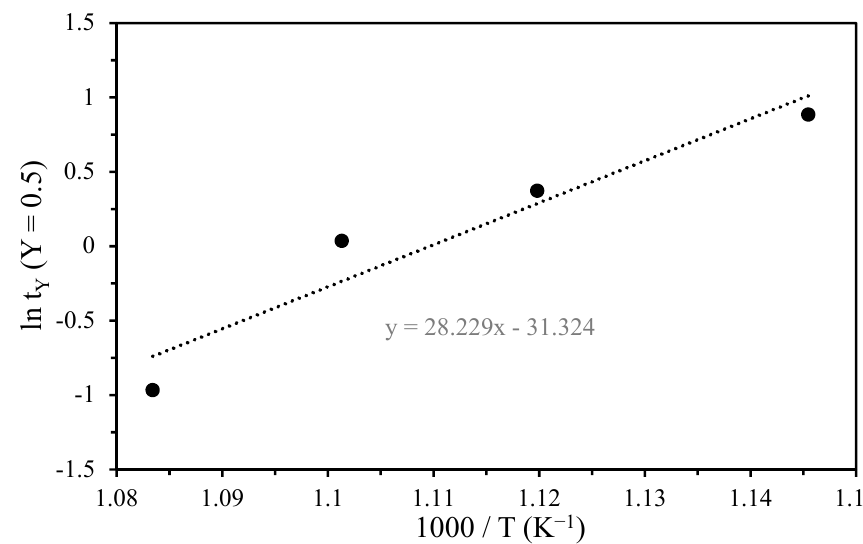
Figure 10. Arrhenius plot corresponding to the fourth mass t loss event (mercury sublimation).